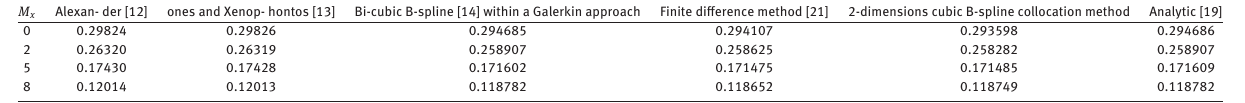
Table 2: U at the centre of the duct